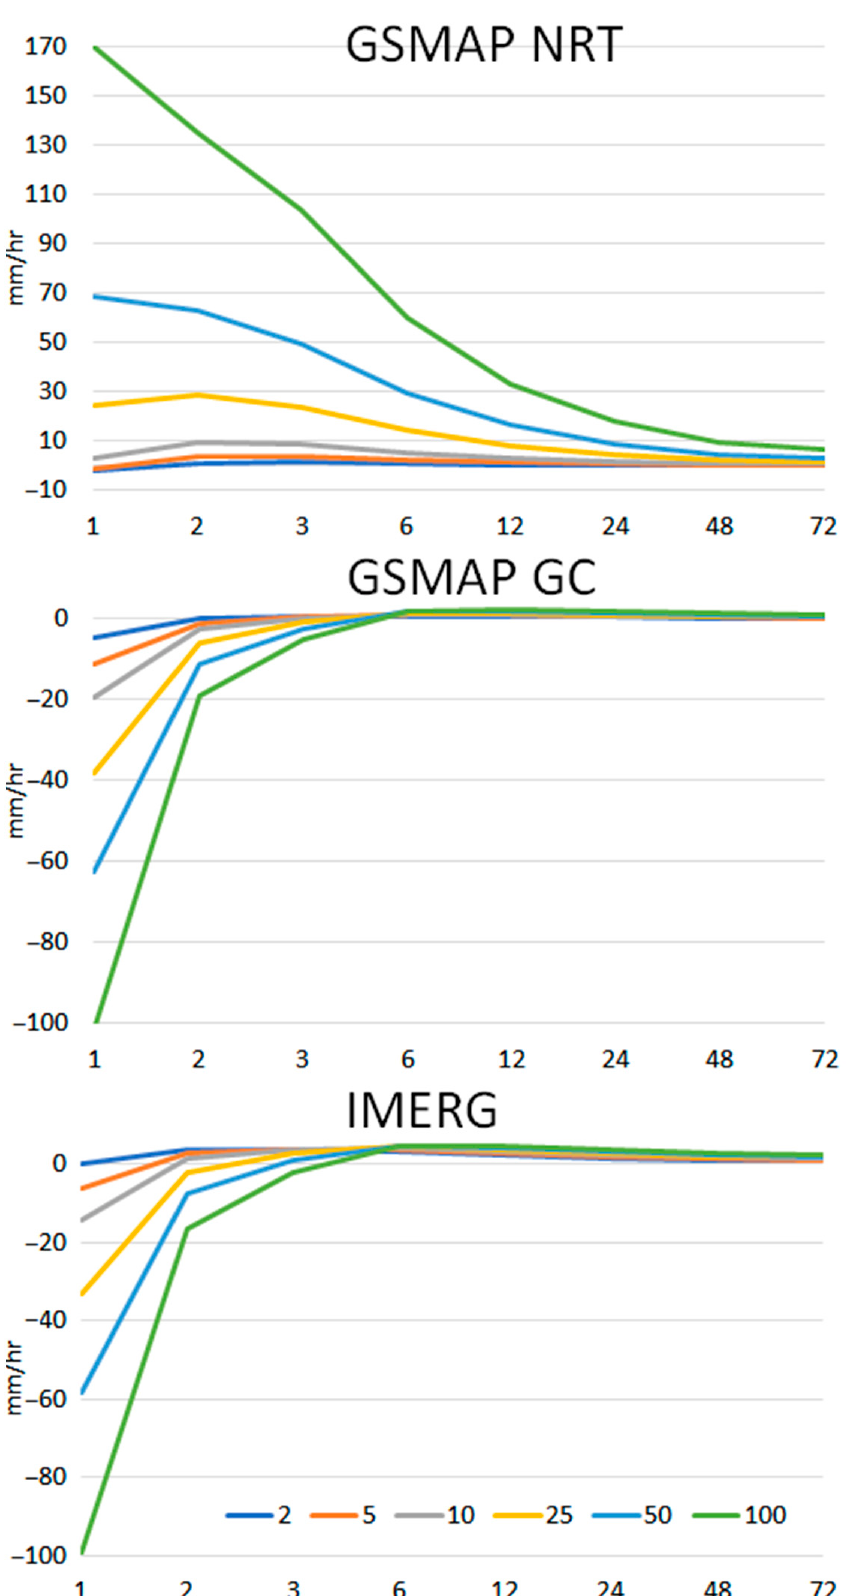
Figure 10. Bias in IDF curves in GSMaP NRT, GSMaP GC, and IMERG data compared to observation at Baghdad.